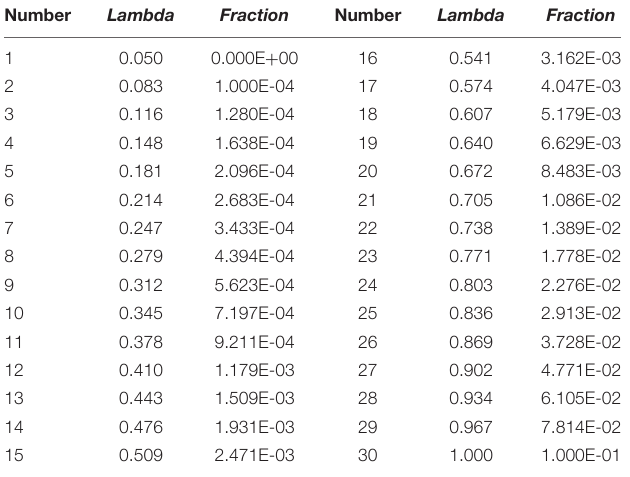
for yield prediction. In the “caret” package, the parameters to be adjusted are the fraction and quadratic penalty parameter lambda . Table 3 represents the candidate ranges of these two parameters.